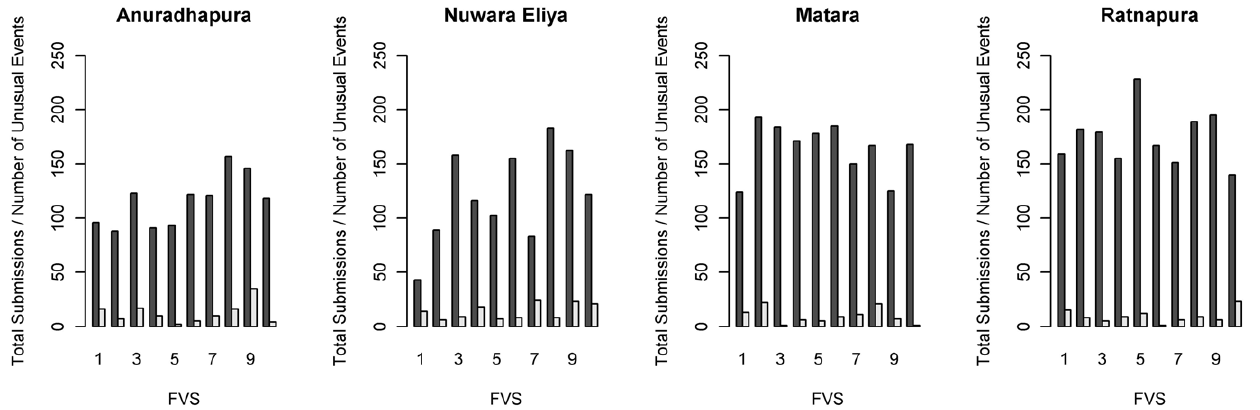
Figure 4. Submission counts and the number of unusual states per veterinarian. Total weekly submissions to the Infectious Disease Surveillance and Analysis System during the study period and the number of unusual states, by field veterinary surgeon and district. The number of weeks in state one (normal) is indicated in dark grey and the number of abnormal events in white.